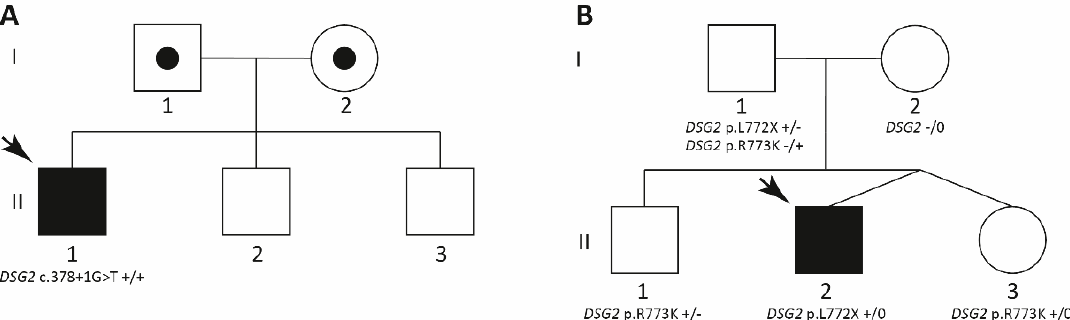
Figure 1. Pedigrees of the described families. (A) Family A has a South Asian origin. The male index patient (II-1) received his diagnosis of arrhythmogenic right ventricular cardiomyopathy (ARVC) at the age of 12. (B) Family B has a Russian origin. Circles represent females, squares males. Black-filled symbols indicate a cardiac phenotype and white symbols indicate healthy family members. +/ − indicates heterozygous, +/+ homozygous, and +/0 hemizygous status. Index patients are marked with an arrow. Obligate carriers are shown with a black dot in the pedigree symbol.